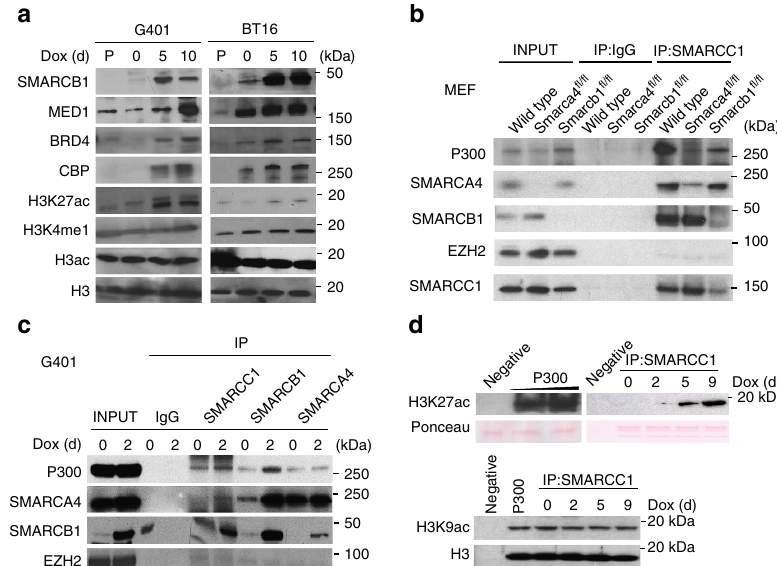
Figure 3 | The SWI/SNF complex physically interacts with enzymes catalysing histone acetylation at enhancers. ( a ) Western blots of selected factors, SMARCB1, enhancer-specific binding factors, histone H3, and different modifications in SMARCB1-deficient rhabdoid cell lines, G401 and BT16. Parental lines (P) and 0, 5 or 10 days after Doxycycline (Dox) induced SMARCB1 re-expression. ( b ). Immunoprecipitation (IP) of the SWI/SNF complex subunit SMARCC1 in wild-type and Smarca4 - or Smarcb1 -deficient MEFs after CRE-inactivation. Immunoblotted for P300, SMARCA4, SMARCB1, SMARCC1 and EZH2. IgG pulldown is shown as control. ( c ) Immunoprecipitation (IP) of the SWI/SNF complex subunits SMARCC1, SMARCB1 or SMARCA4 from the nuclear extracts of G401 cell line with or without Doxycycline (Dox) induced SMARCB1 re-expression. Immunoblotted for P300, SMARCA4, SMARCB1, and EZH2. IgG is shown as control. ( d ) In vitro HAT assay with Acetyl-CoA as donor group and detection of histone acetylation by immunoblot using H3K27ac, H3K9ac, and H3 antibodies. After pulling down the SWI/SNF complex with SMARCC1 antibody, acetylation activity was measured in the presence or absence of SMARCB1 expression. Ponceau staining was shown as loading control for